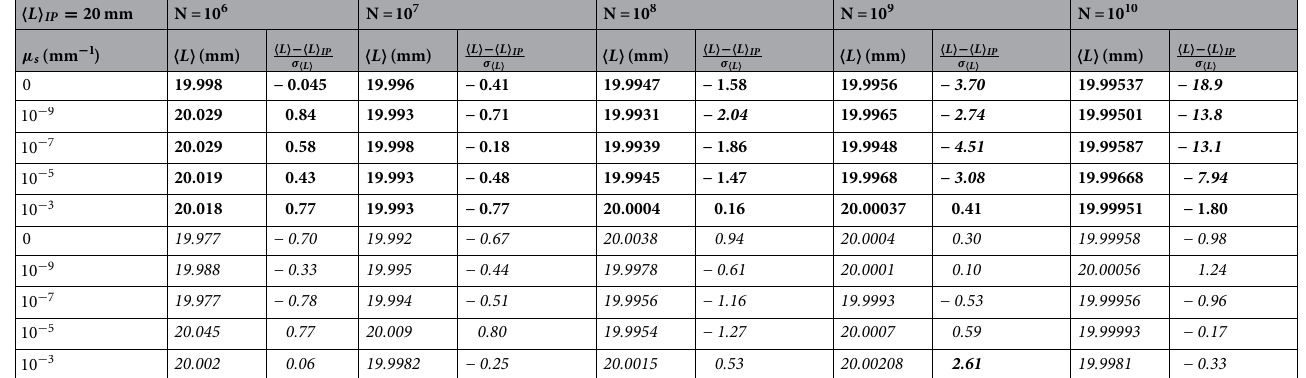
Table 3. The effect of a single-precision (first five rows, in bold) random number generator compared to a double-precision one (last five rows, in italic) in a laterally infinite extended slab of thickness 10 mm ( 20 mm) for n 1 , and for different values of the scattering coefficient. The t statistics � r = calculation are reported. The bolditalic values are the ones that can be rejected with the confidence level of